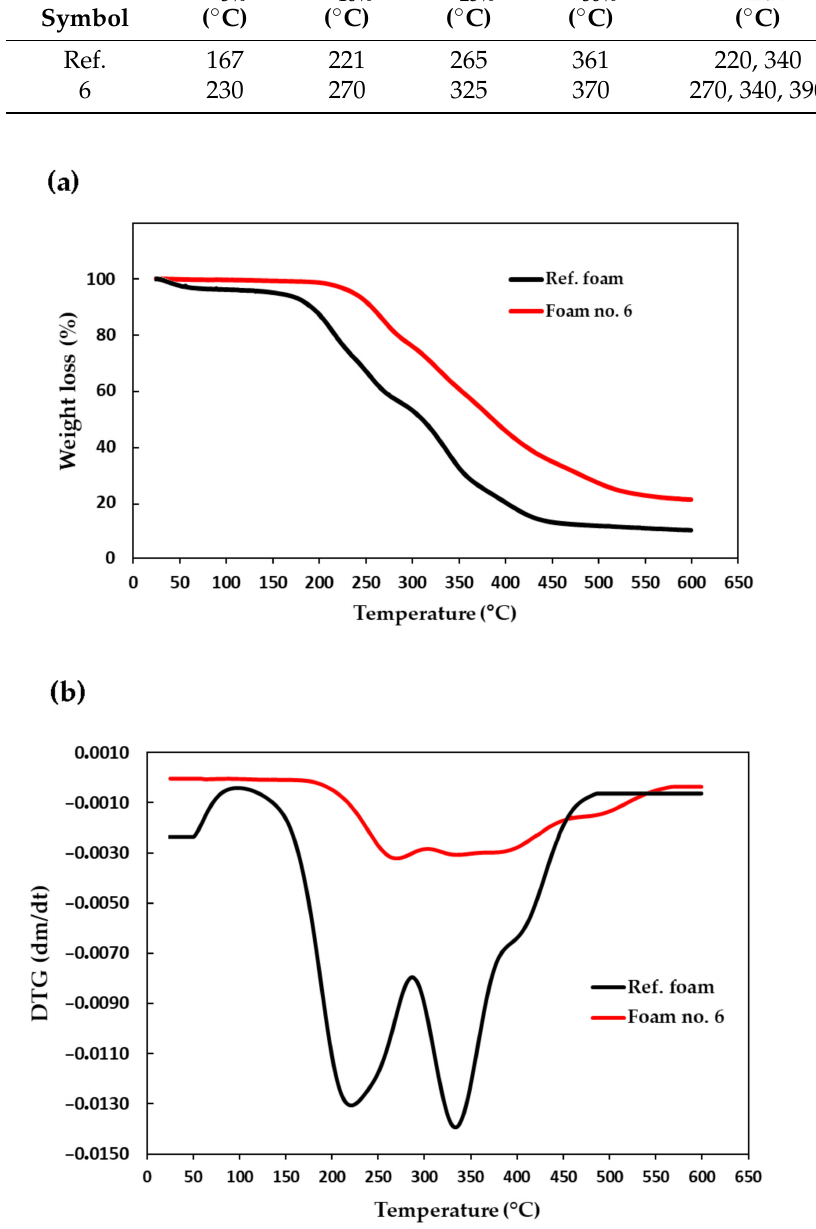
Figure 5. TG ( a ) and DTG ( b ) curves of reference foam (Ref.) and foam based on mixture of polyols (no.